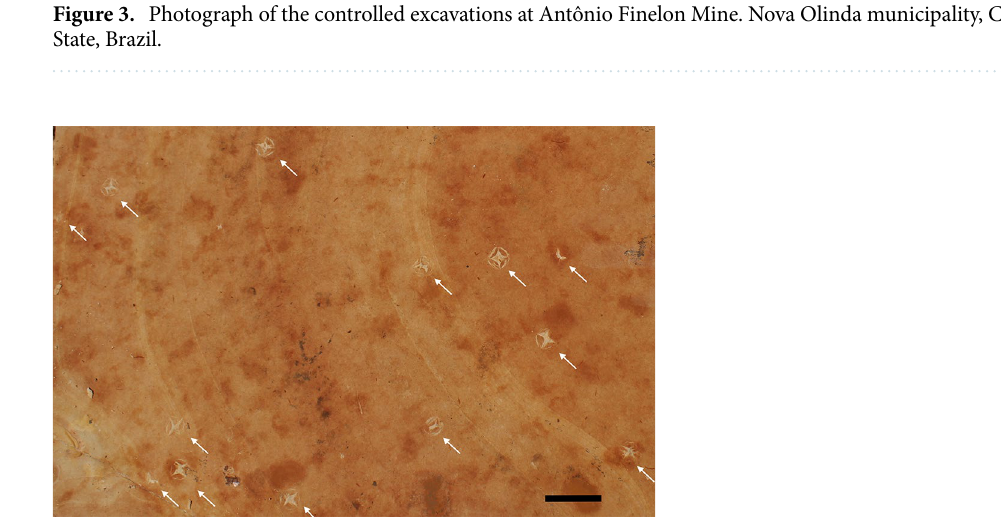
Figure 4. Halite crystals. Halite crystals recovered from layer 288 cm. White arrows point to crystals. Scale bar 20 mm.